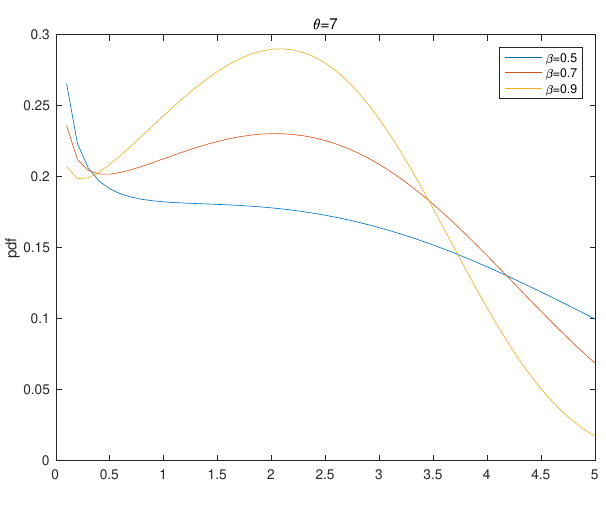
Figure 4. The pdf when β ≤ 1, θ >